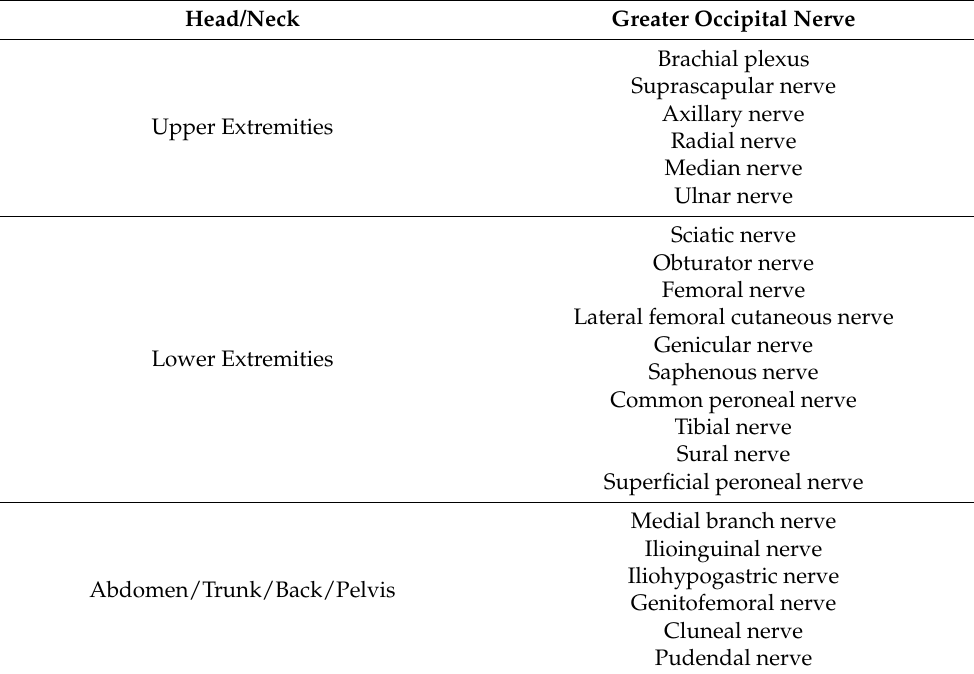
Table 1. Peripheral Nerves Commonly Used for